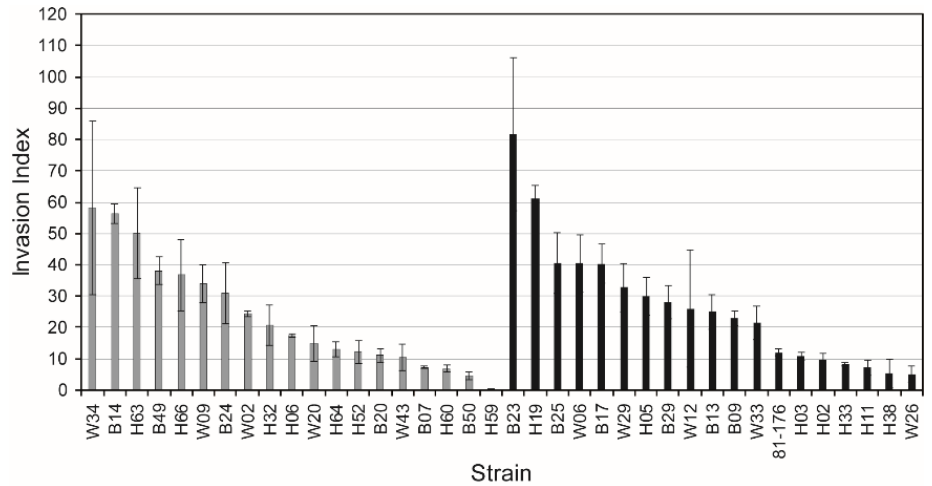
Figure 4. Relation between invasion index and LOS SIAL production in C. jejuni strains. The invasion index was calculated as the percentage of intracellular cells from the total cell-associated bacteria after 3 h infection of Caco-2 cells with the indicated strains. The average and standard deviation of three independent experiments are shown. Grey and black bars indicate strains that express or do not express LOS SIAL , respectively.